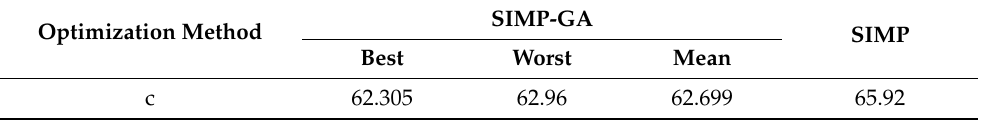
Figure 8. Final results from 10 runs of cantilever beam. Table 2. Comparison of MBB beam optimization results.